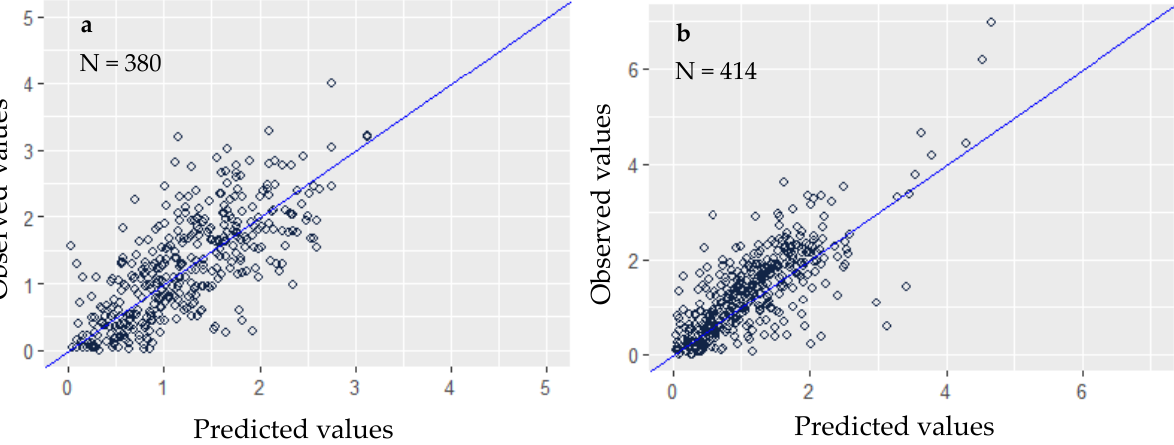
Figure 8. Observed merchantable top length plotted against predicted values with a line of unity for ( a ) white spruce and ( b ) balsam fir.